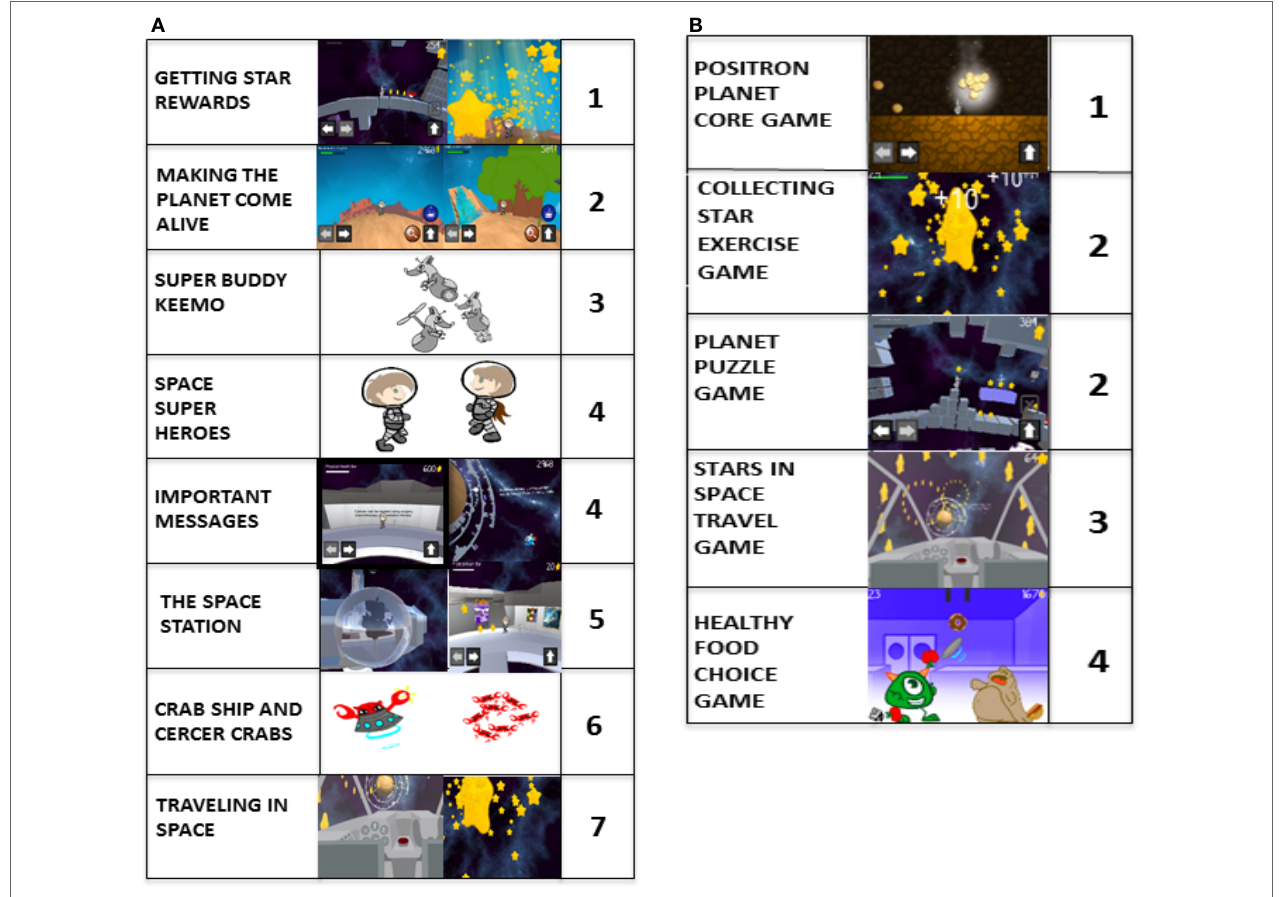
FigUre 11 | Mean responses of the 9 of 10 pediatric subjects who were able to rank-order two distinct picture scales. (a) Of the eight major game components, collecting the star rewards was the most liked (1) and traveling in space was the least liked (7). The Space Heroes and the important messages were tied for the fourth most liked. (B) Of the five distinct exercise mini-games, the Positron game was the most liked (1) and the healthy food choice game was the lease liked. The star exercise mini-game and the planet puzzle game tied for the second most